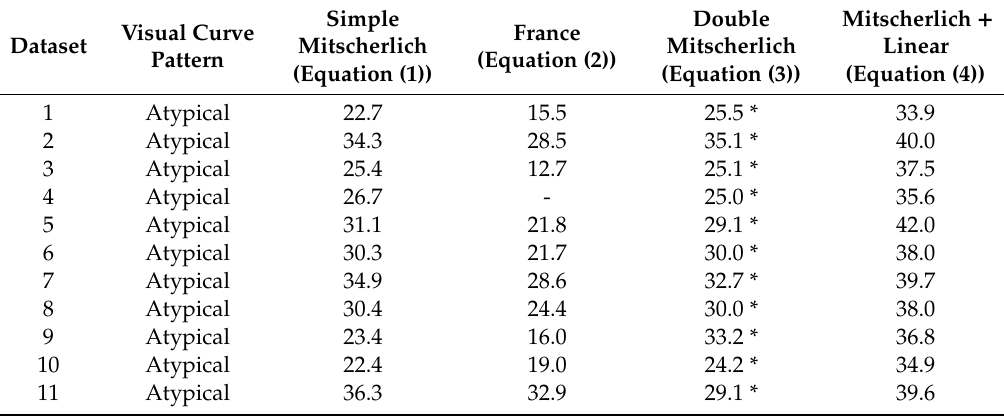
Table 5. Calculated extent of degradation (%) from the 14 datasets of Experiment 1 displaying atypical gas production profiles and the 11 datasets of Experiment 2 displaying both typical and atypical profiles. An asterisk (*) denotes the equation that resulted in the best fit, based on AIC, to a particular